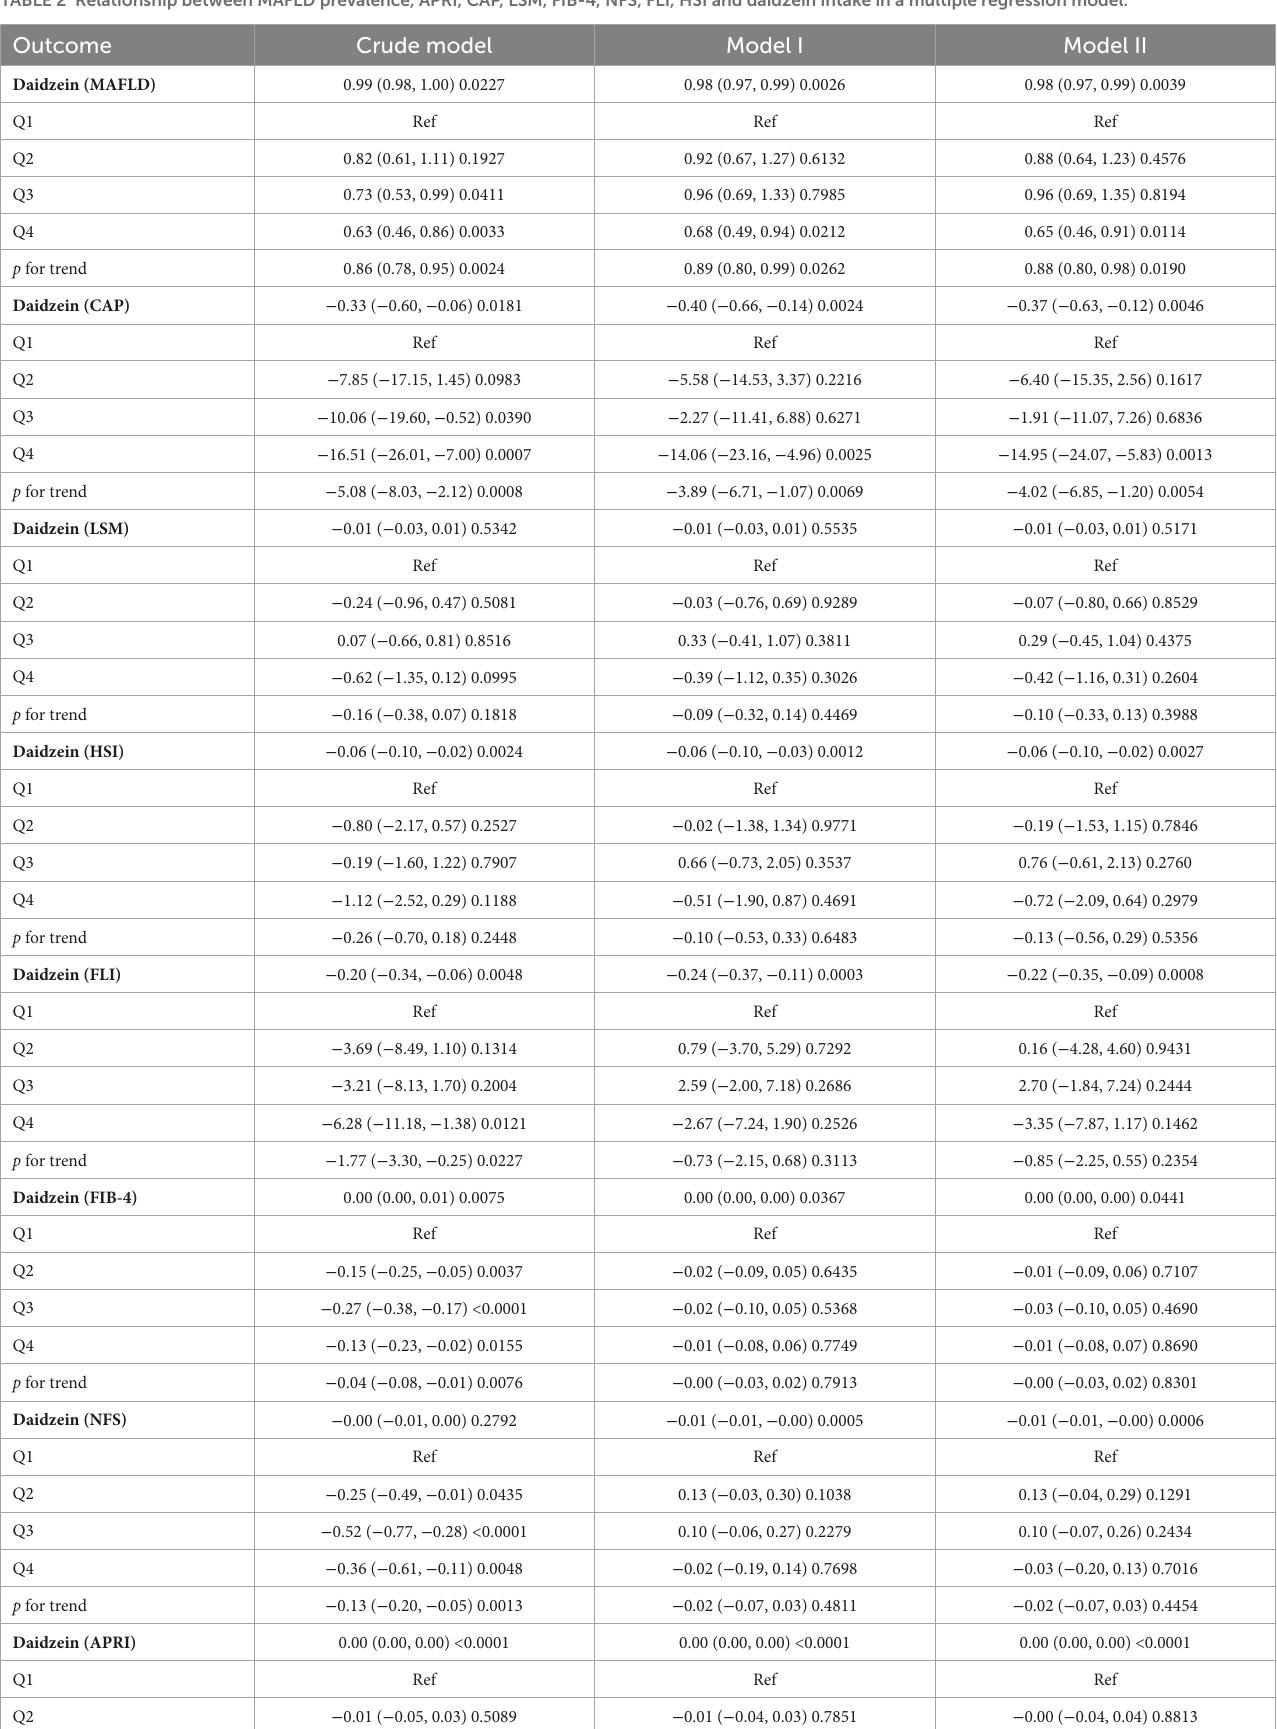
TABLE 2 Relationship between MAFLD prevalence, APRI, CAP, LSM, FIB-4, NFS, FLI, HSI and daidzein intake in a multiple regression model. Outcome Crude